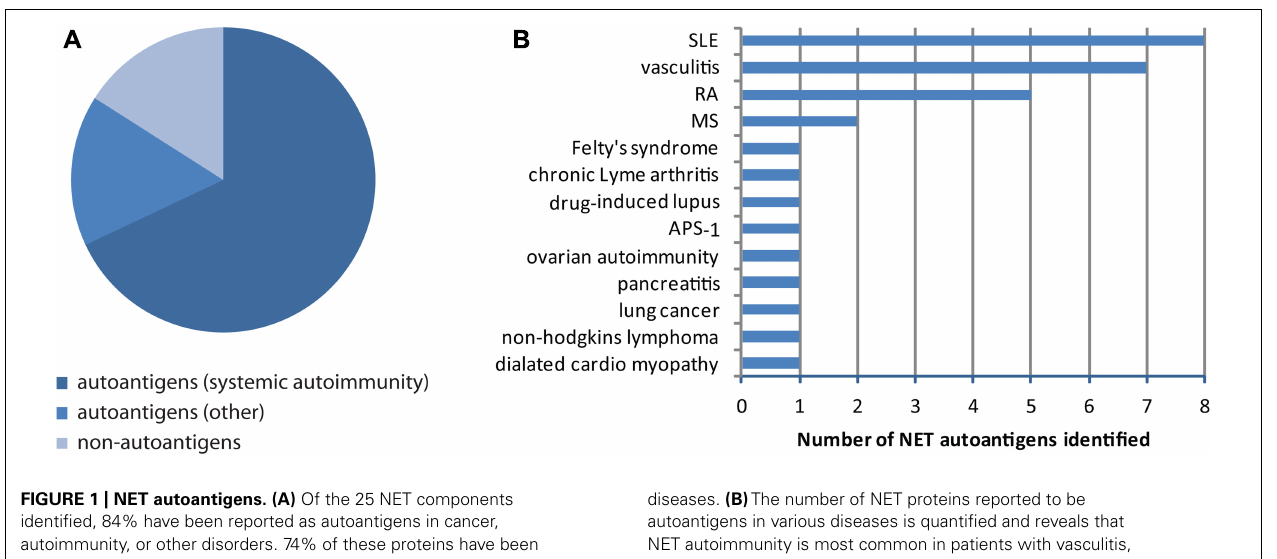
FIGURE 1 | NET autoantigens. (A) Of the 25 NET components identified, 84% have been reported as autoantigens in cancer, autoimmunity, or other disorders. 74% of these proteins have been reported to be the target of autoantibodies in systemic autoimmune